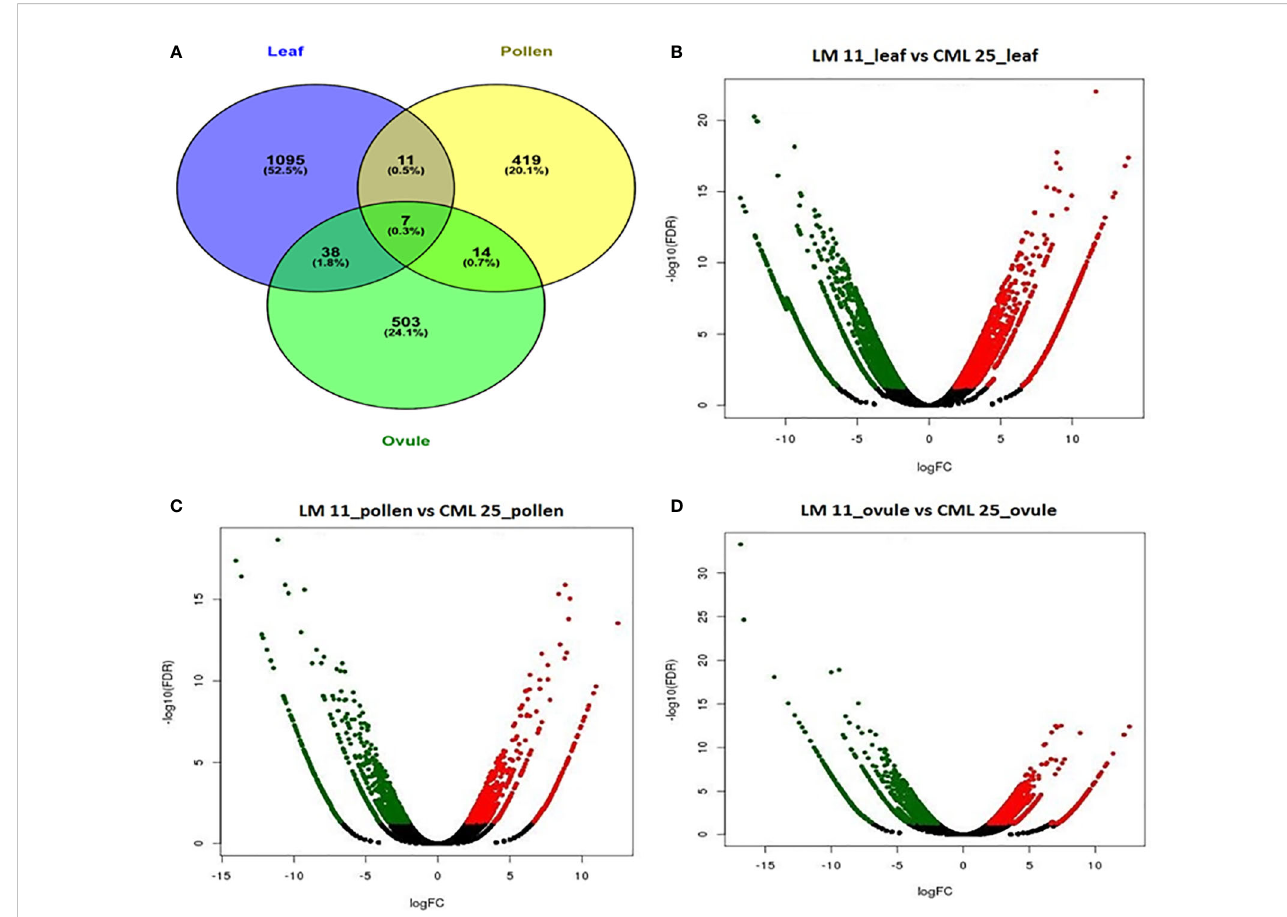
FIGURE 2 Differentially expressed genes (DEGs) involved in response to heat stress in maize at reproductive stage from three different tissues. (A) Venn diagram of DEGs in response to changes in leaf, pollen, and ovule. (B) Volcanic plot displaying DEGs in leaf of LM11 (S) versus CML 25 (T). (C) Volcanic plot displaying DEGs in pollen of LM 11 (S) versus CML 25 (T). (D) Volcanic plot displaying DEGs in ovule of LM 11 (S) versus CML 25 (T). Red dots represent up-regulated DEGs; green dots represent down-regulated DEGs. The x-axis values correspond to the log 2 (fold change) value; the y-axis corresponds to the mean expression value of the − log10 (p-value) between LM 11 and CML 25. The Volcano plots for differentially expressed transcripts represent FDR ≤ 0.05 and |log 2 (fold change) ≥